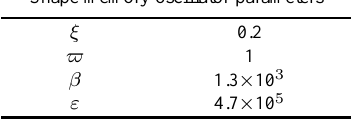
Fig. 8. Evolution of Poincar´e maps due to variation of the force amplitude parameter δ (formation of a periodic window). (a) δ = 0 . 0683 , chaos; (b) δ = 0 . 06845 , chaos; (c) δ = 0 . 0685 , chaos; (d) δ = 0 . 0686 , chaos; (e) δ = 0 . 0687 , chaos; (f) δ = 0 . 0692 , period-5; (g) δ = 0 . 0693 , chaos; (h) δ = 0 . 0694 , chaos; (i) δ = 0 . 0695 , chaos. Table 1 Shape memory oscillator